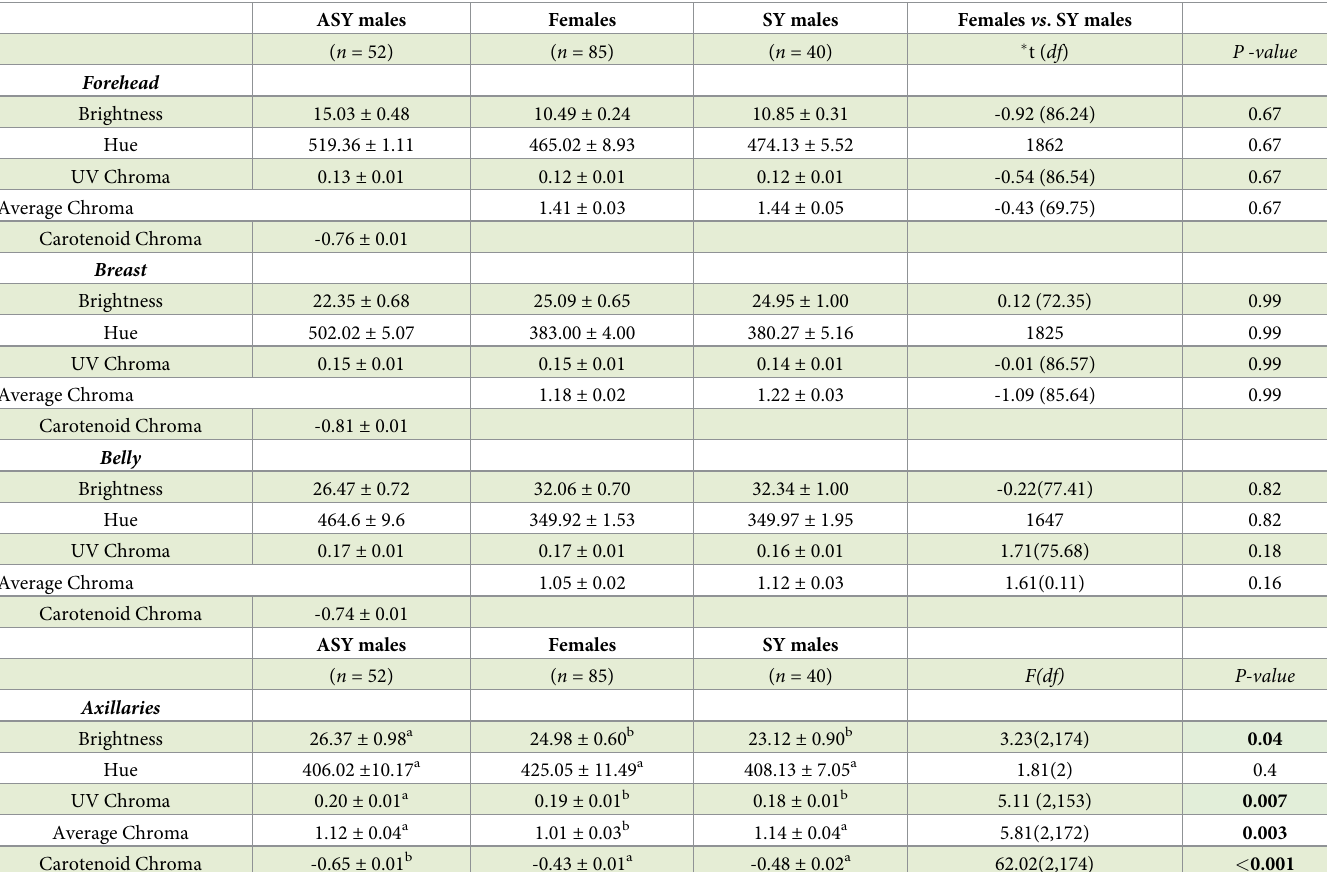
Table 1. Color description of Saffron Finches after second-year males, females, and second-year males, and comparisons between the latter two groups. Significant results are shown in bold. ASY males Females SY males Females vs . SY males ( n = 52) ( n = 85) ( n = 40) � t ( df ) P